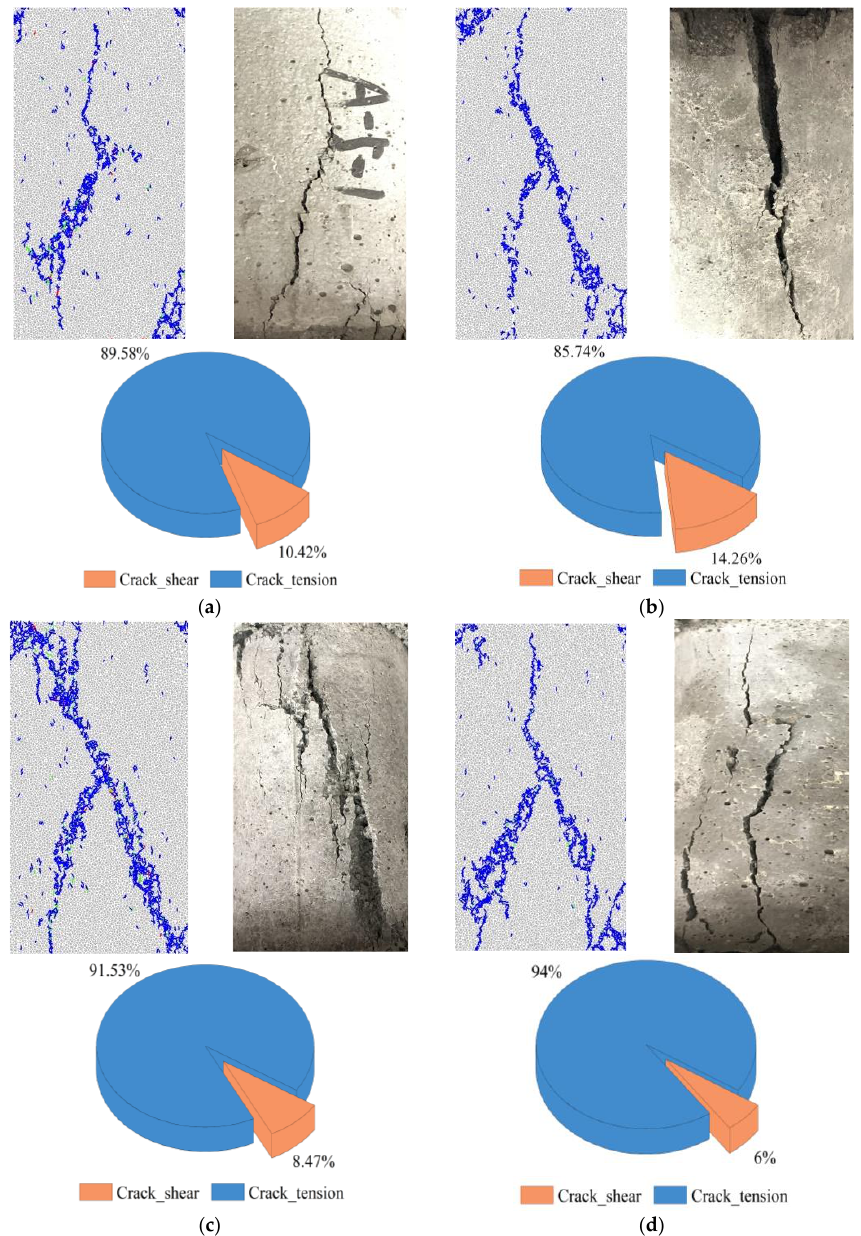
Figure 9. Sample destruction mode under different freeze-thaw cycles: ( a ) 0 F-T cycle; ( b ) 10 F-T cycle; ( c ) 20 F-T cycle; and ( d ) 30 F-T cycle.